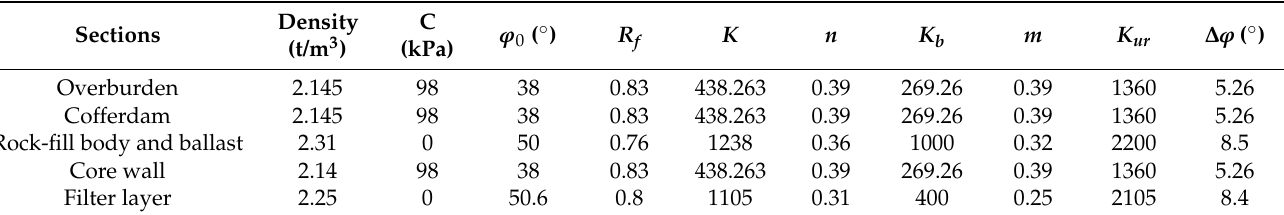
Figure 7. Monitoring compression values of the bottom of the core wall. Table 5. Material parameters for design.